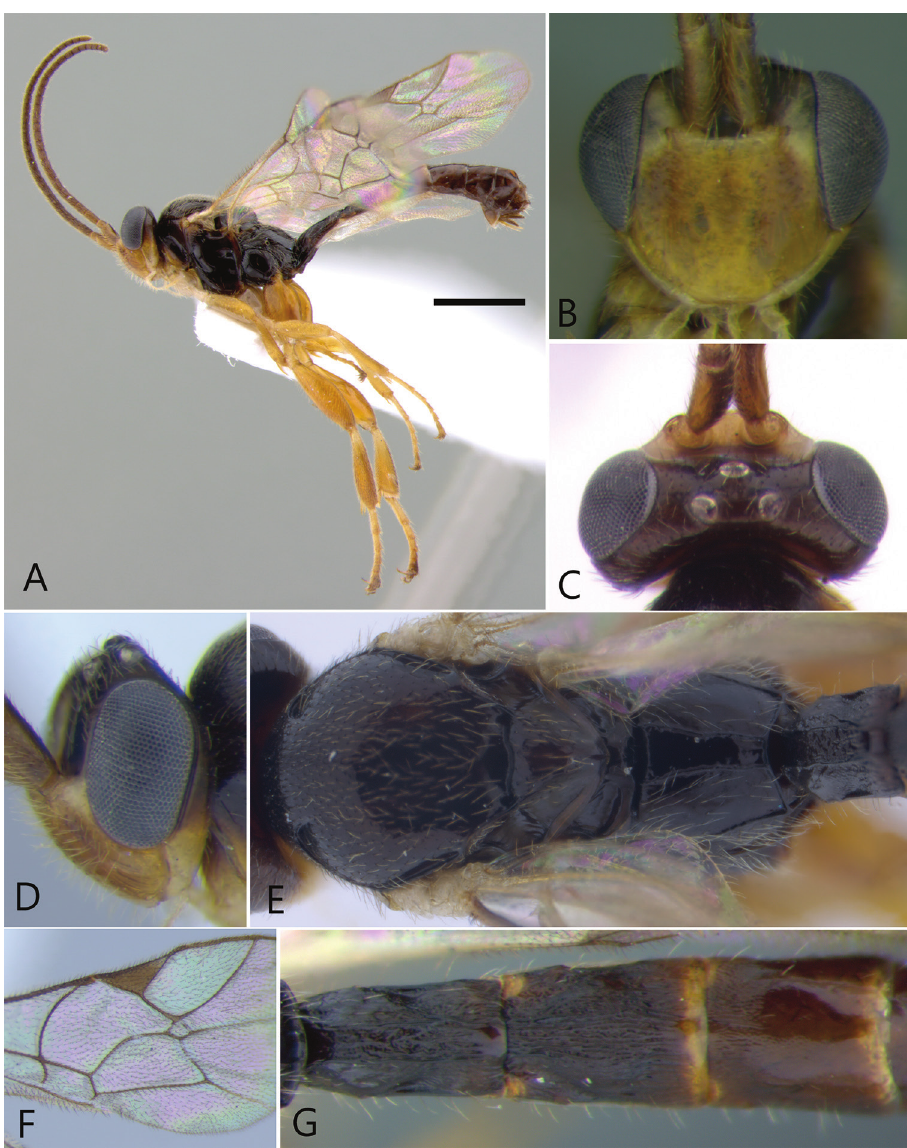
Figure 7. Orthocentrus koreanus sp. nov. Holotype. A Habitus in lateral view B head in frontal view C head in dorsal view D head in lateral view E mesosoma in dorsal view F areolet G first to third tergites in dorsal view. 10. Orthocentrus leei Humala & Choi, sp. nov. http://zoobank.org/24556892-5675-4781-978D-F79A4D583427 Fig. 8 Description. Female. Fore wing length 2.9